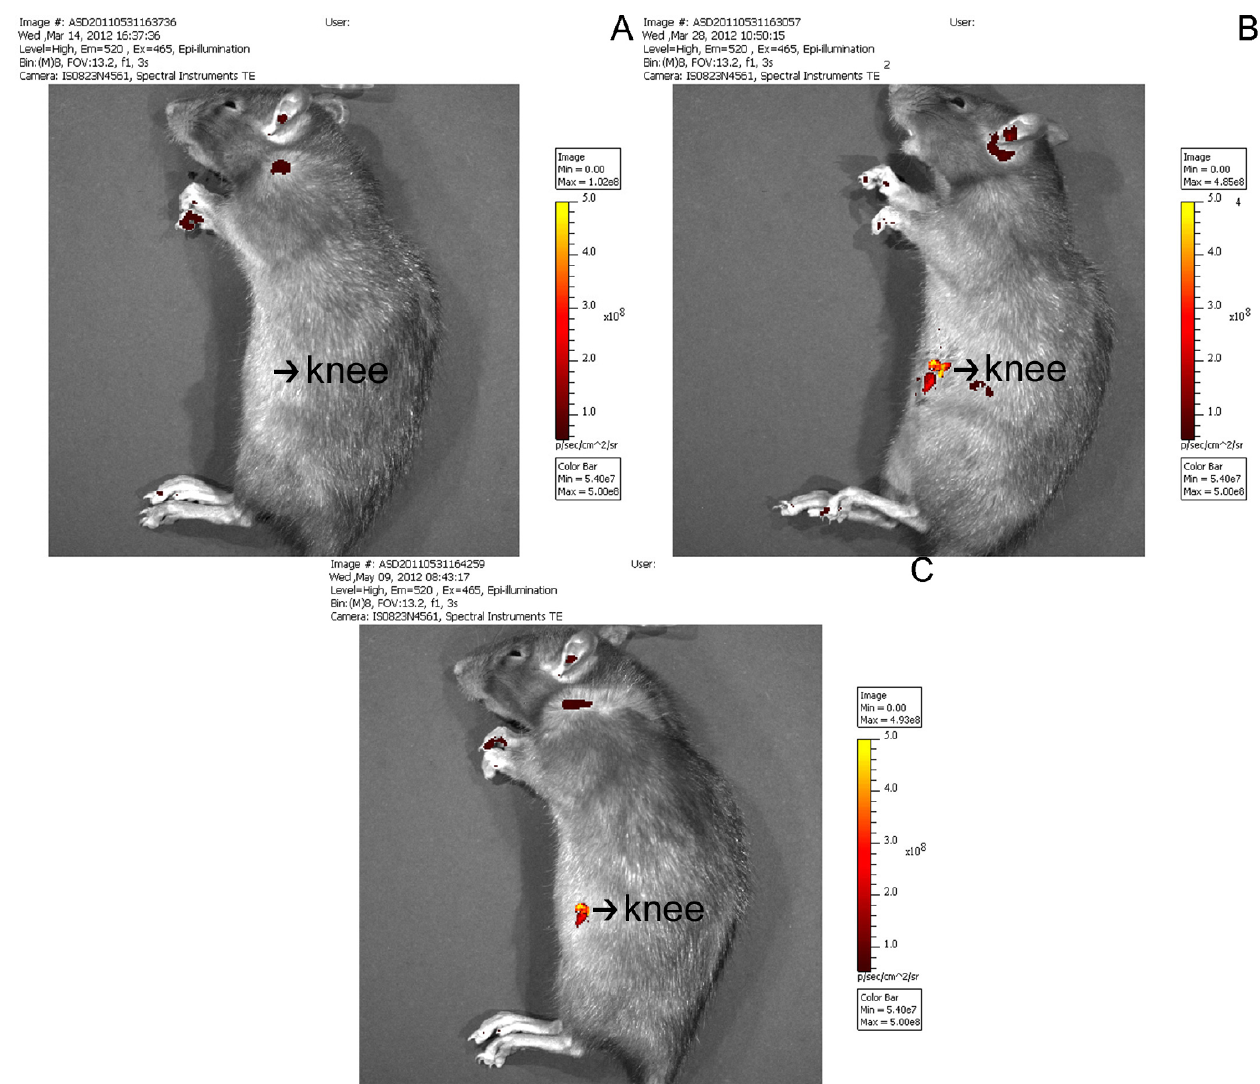
1. ( A ) Fluorescence images of the operated contracture (ORC) group; ( B , C ) Representative fluorescence images of rat tissue in the contracture-treatment (CNT) group at 2 weeks after operation ( B ) and 8 weeks after operation ( C